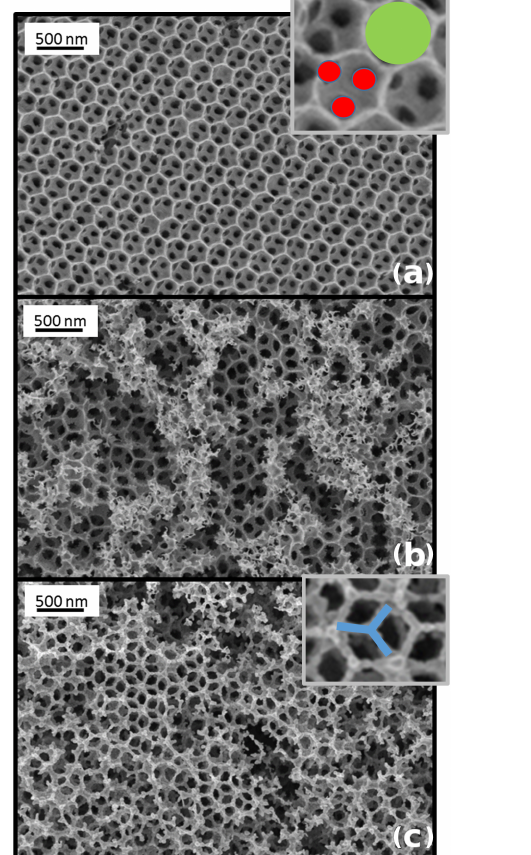
Figure 7. SEM images of the inverse opal structures: as synthe- sized (a) , annealed at 450 ◦ C (b) and at 550 ◦ C for 5 + 72h (c) . Insets show zoomed out region of (a) and (c) with spherical pore marked in green, windows connecting pores in red and rods form- ing after 550 ◦ C treatment in